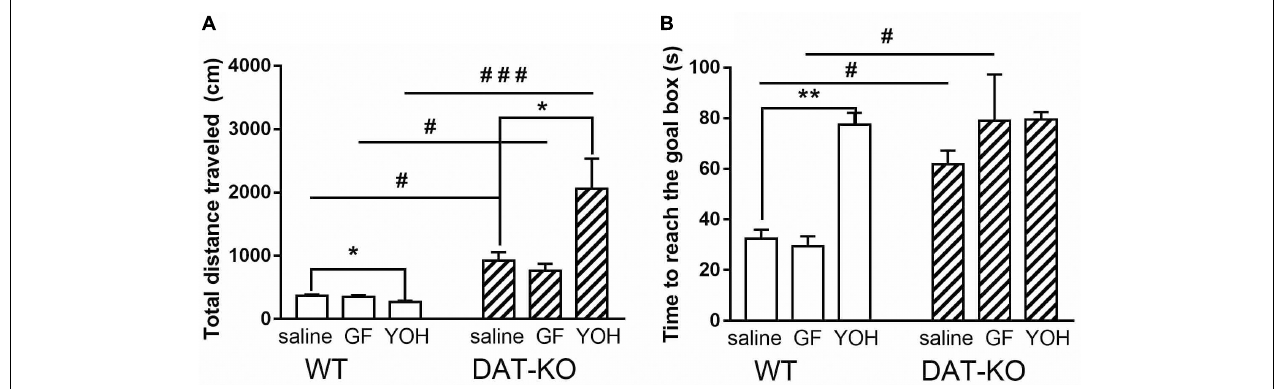
FIGURE 3 | Comparison of distances traveled (A) and time to reach the goal box (B) by DAT-KO and WT rats during three experimental sessions; # p < 0.05; ### p < 0.001; one-way Kruskal–Wallis test combined with Dunn’s multiple-comparison post hoc test; * p < 0.05; ** p < 0.01; Mann-Whitney test; WT, wild-type; DAT-KO, dopamine transporter knockout rats.